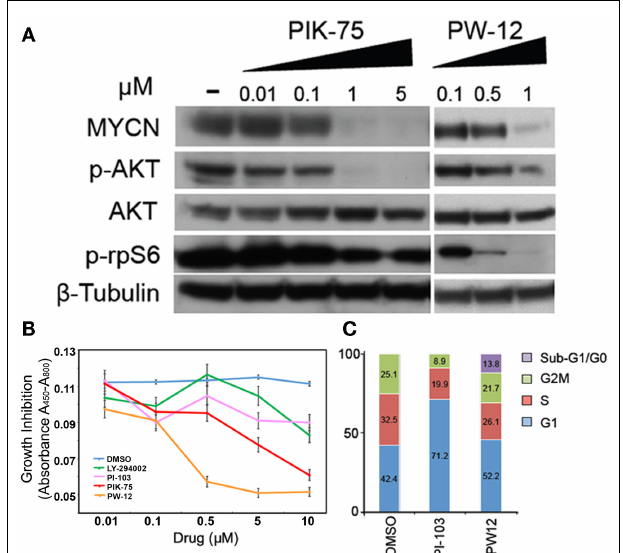
FIGURE 1 | Inhibitors of PI3K downregulate MYCN protein, increase apoptosis, and decrease viability in MYCN-amplified tumor cells . (A) Kelly MYCN-amplified neuroblastoma cells were treated for 24h with the indicated concentrations of inhibitor (PIK-75 or PW-12) and blotted for MYCN and markers downstream of PI3K (pAKT) and mTOR (prpS6). (B) Kelly neuroblastoma cells were treated with inhibitor (LY-294002, PI-103, PIK-75, PW-12, or DMSO) for 48h and cell proliferation was measured by WST1 assay. (C) Kelly neuroblastoma cells were treated with 1 µ M of inhibitor (PI-103, PW-12) for 48h and cell cycle effects were analyzed by flow